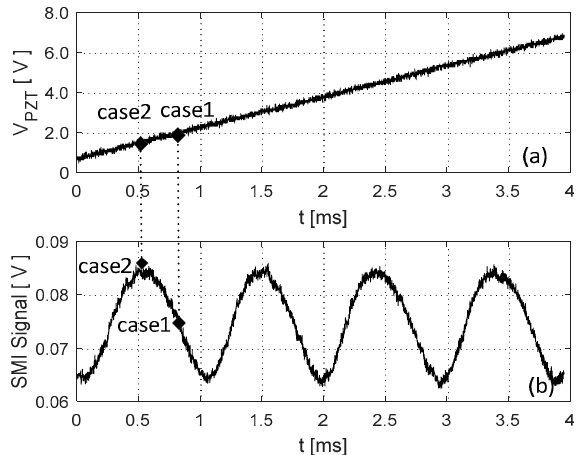
Figure 6. Experimental self-mixing interferometry (SMI) signal ( a ) control signal applied on PZT; ( b ) corresponding SMI signal.